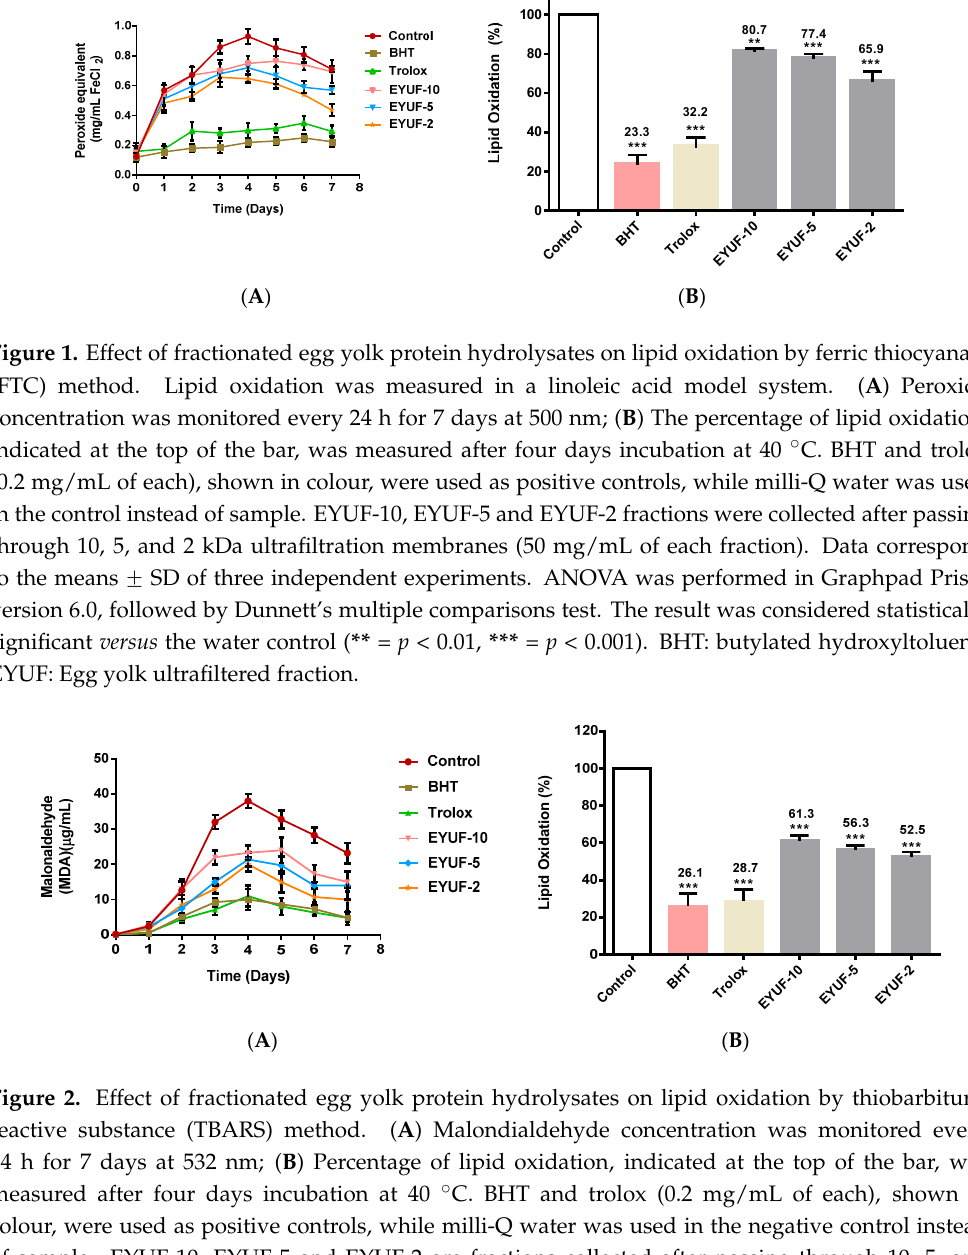
lipid oxidation was observed for the 2 kDa fraction (52.5%) followed by 5 kDa (56.3%) then 10 kDa (61.3%). The presence of BHT and trolox in a linoleic acid model system significantly inhibited lipid oxidation to 26.1% and 28.7%, respectively, when compared to the negative control ( p < 0.001 for both; Figure 2B).